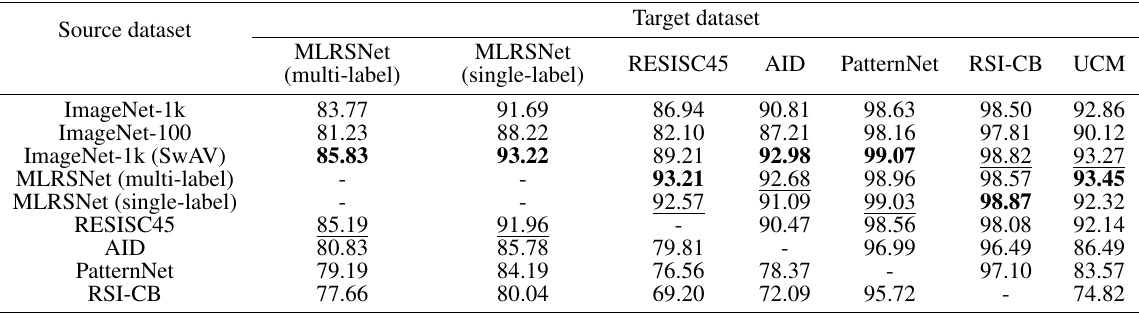
Table 2. Test accuracies/F1-measures (%) with 95% confidence intervals of models trained/fine-tuned on 80% of the images from the HRRS datasets.